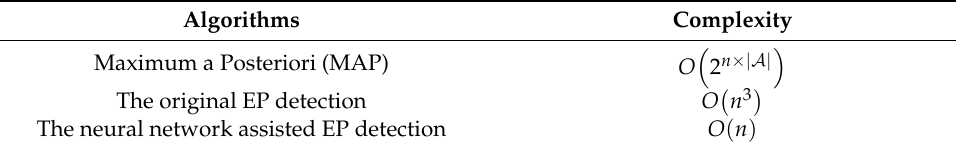
Table 3. Computational complexity